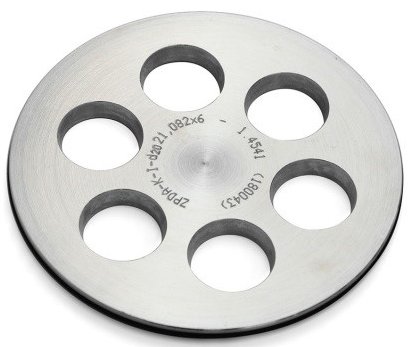
Figure 5: Multi-nozzle flange